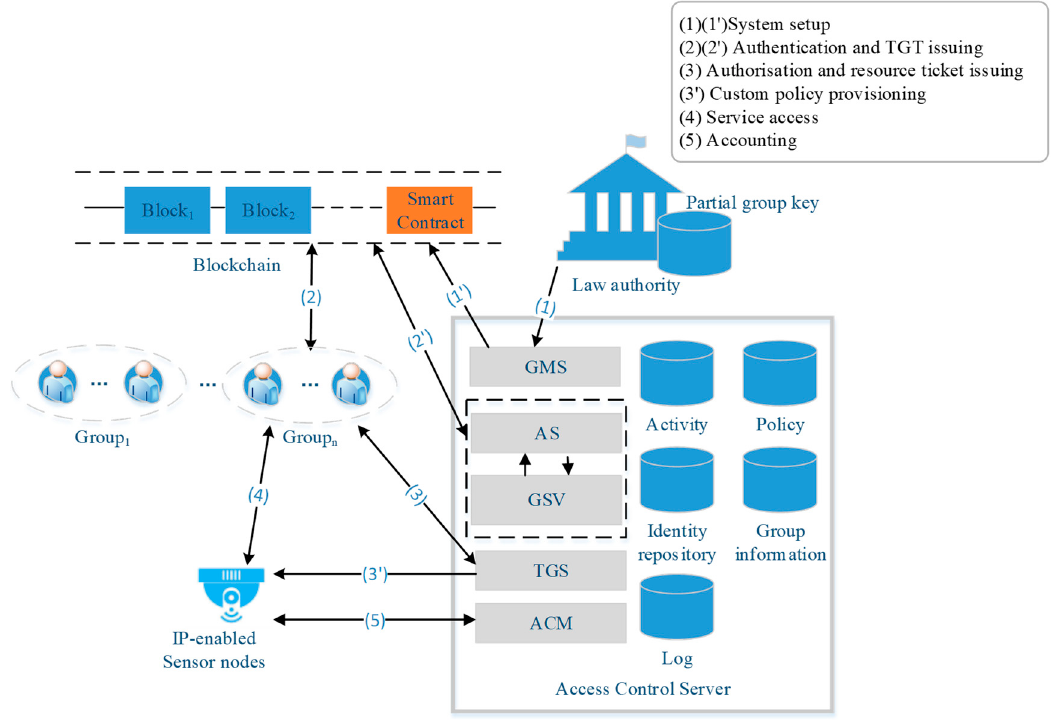
Figure 2. The proposed eHAPAC model.